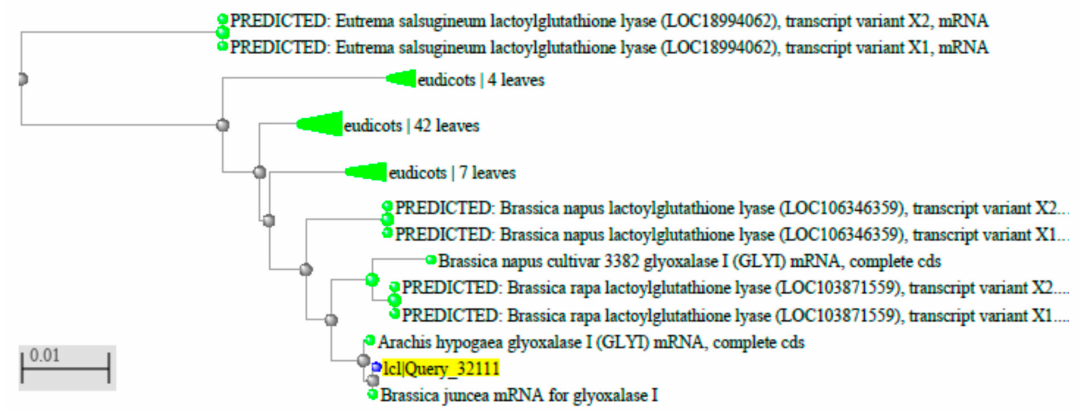
Figure 10. Phylogenetic relationships between the Jojo-GlyI gene using the gene structure predictions and conversed protein motifs. Phylogenetic analysis of glyoxalase I gene in jojoba, Arabidopsis , Brassica napus , Arachis hypogaea